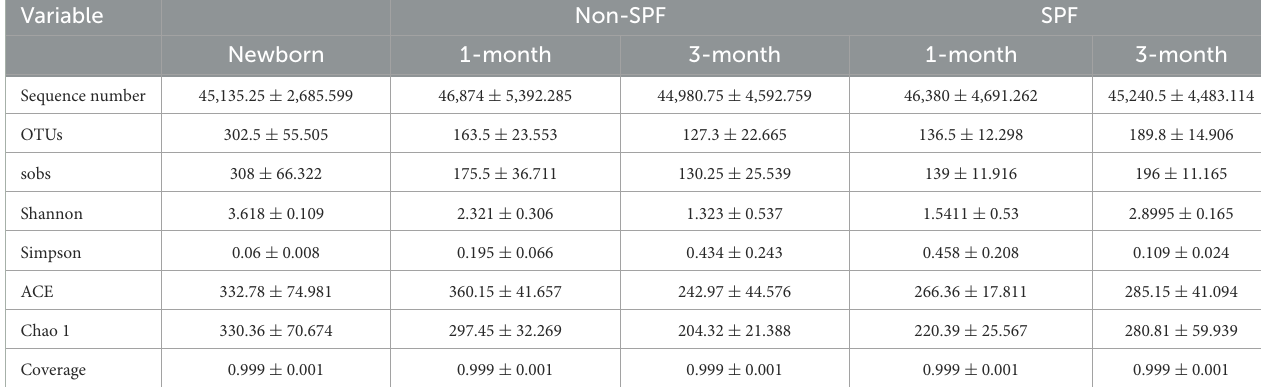
TABLE 1 Number of sequences, number of OTUs and alpha diversity indexes retrieved.